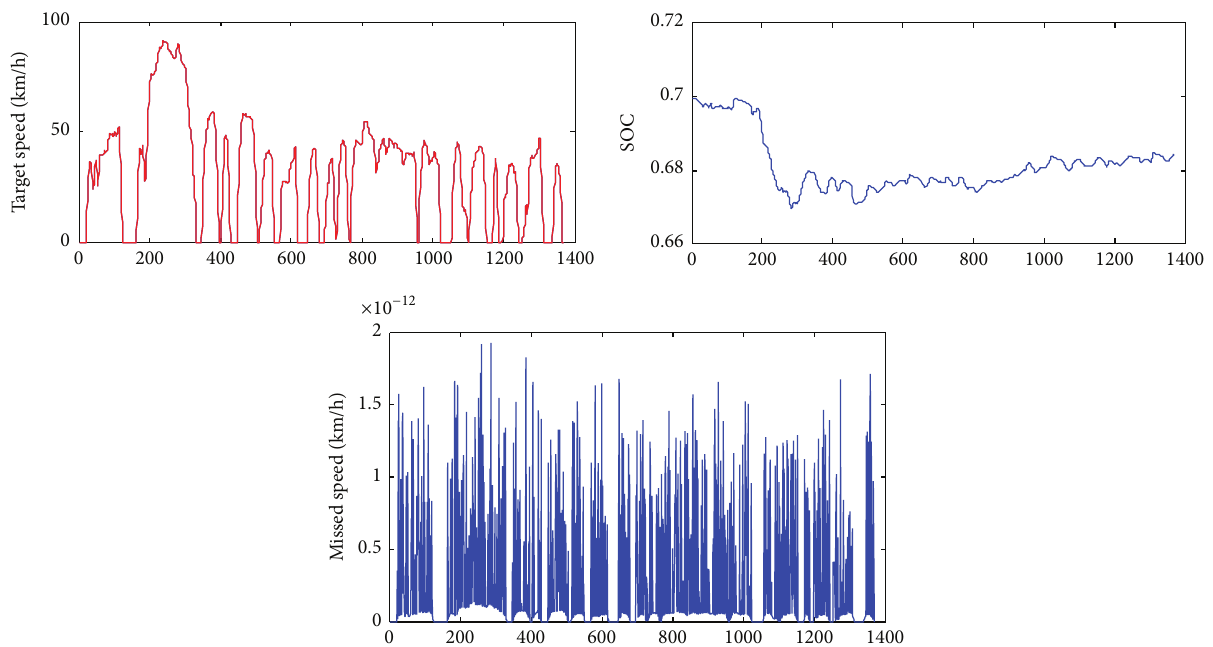
Figure 8: Missed speed and SOC history over UDDS driving